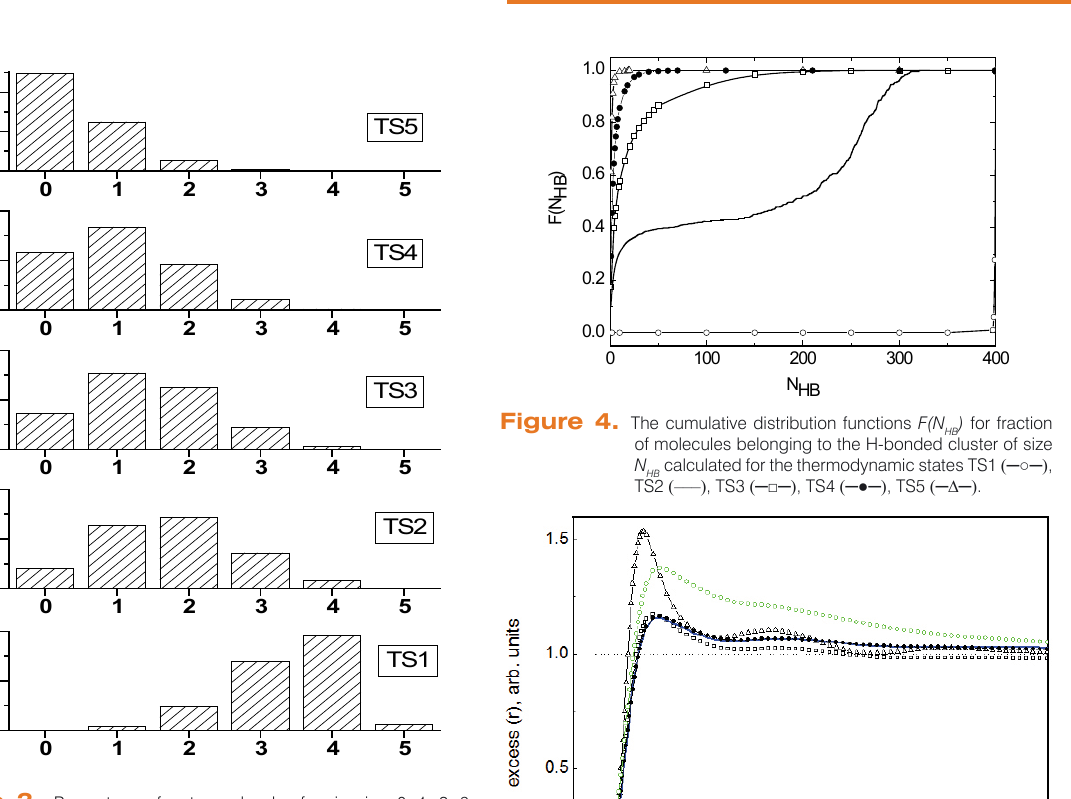
Figure 3. Percentage of water molecules forming i = 0, 1, 2, 3, 4, 5 hydrogen bonds calculated for the thermodynamic states listed in Table 1.